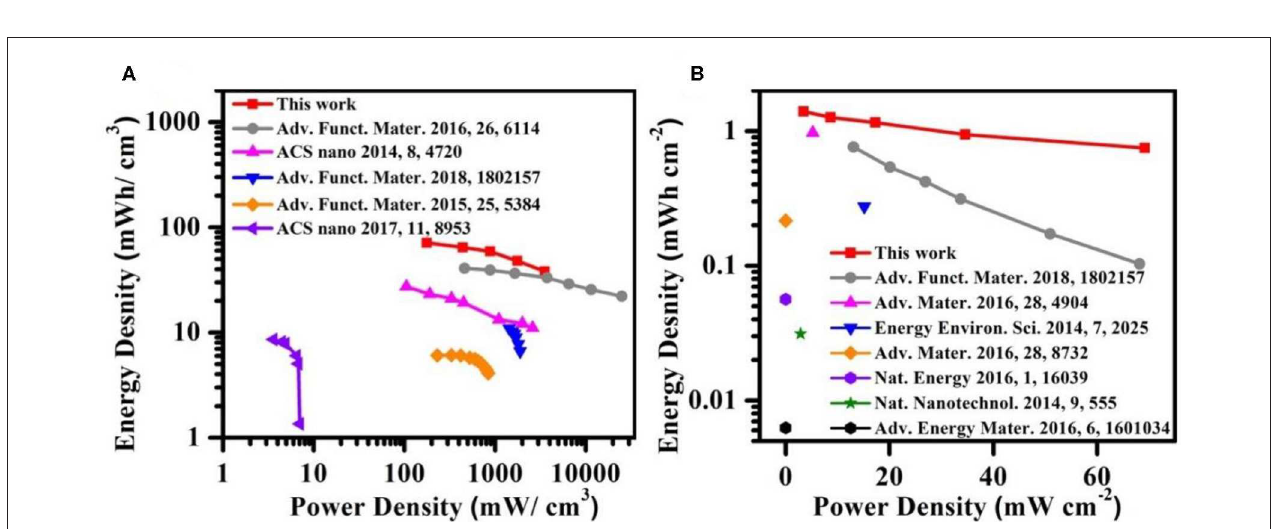
FIGURE 6 | Ragone plots of the device based on (A) the volume and (B) the area of the device. The values reported from other electrochemical energy storage devices are included for comparison.